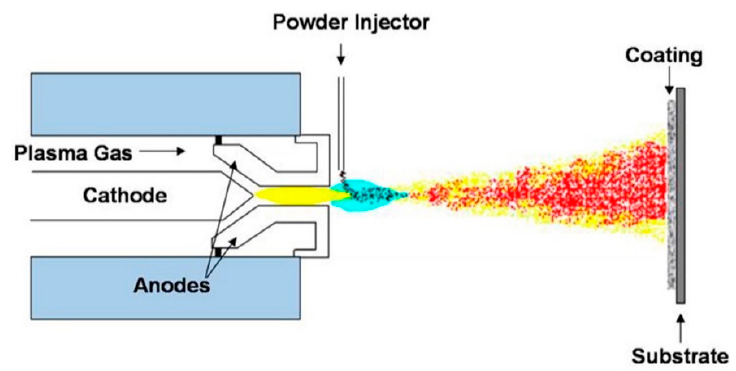
Figure 5. Schematic plasma spray coating technique and the targeted substrate [89].